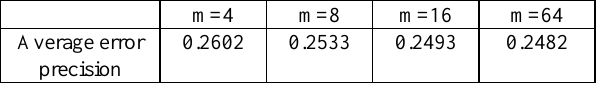
Table 1. Average error precision